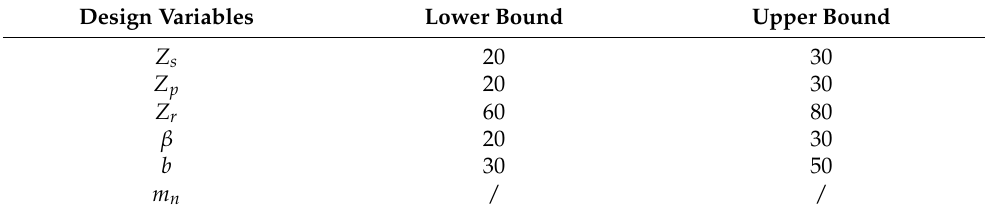
Table 2. Design variables. Design